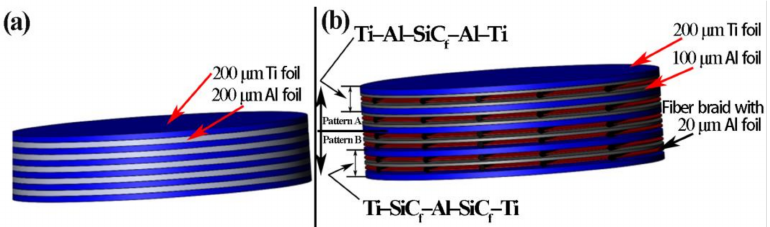
Figure 3. Schematic illustration of the stacking sequence: ( a ) Ti–Al–Ti; ( b ) Pattern A: Ti–Al–SiC f –Al–Ti and Pattern B: Ti–SiC f –Al–SiC f –Ti.